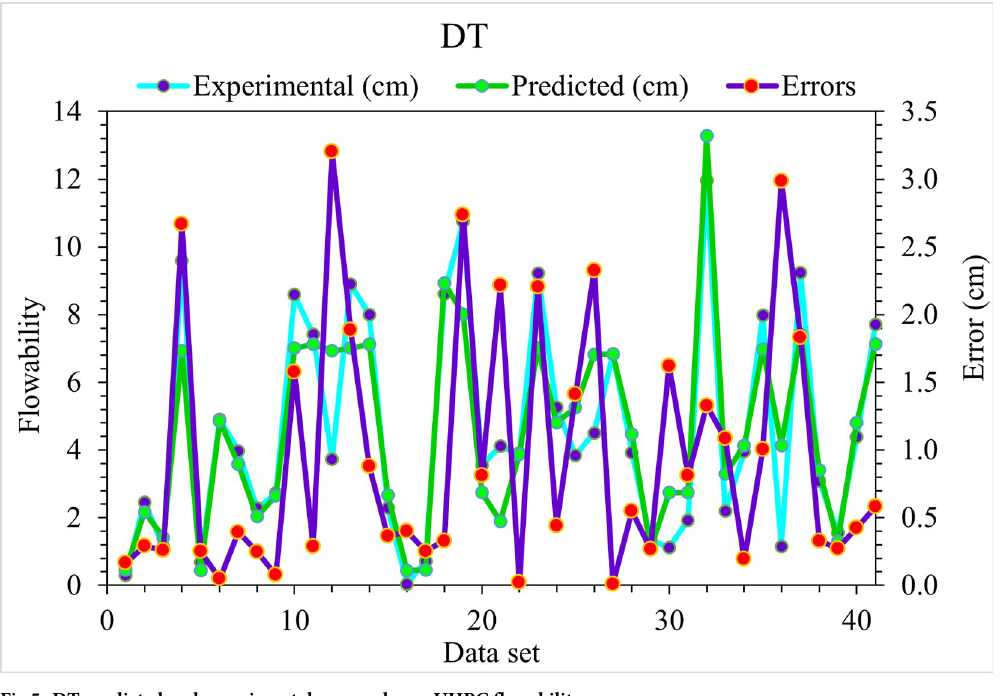
Fig 5. DT predicted and experimental error values—UHPC flowability.